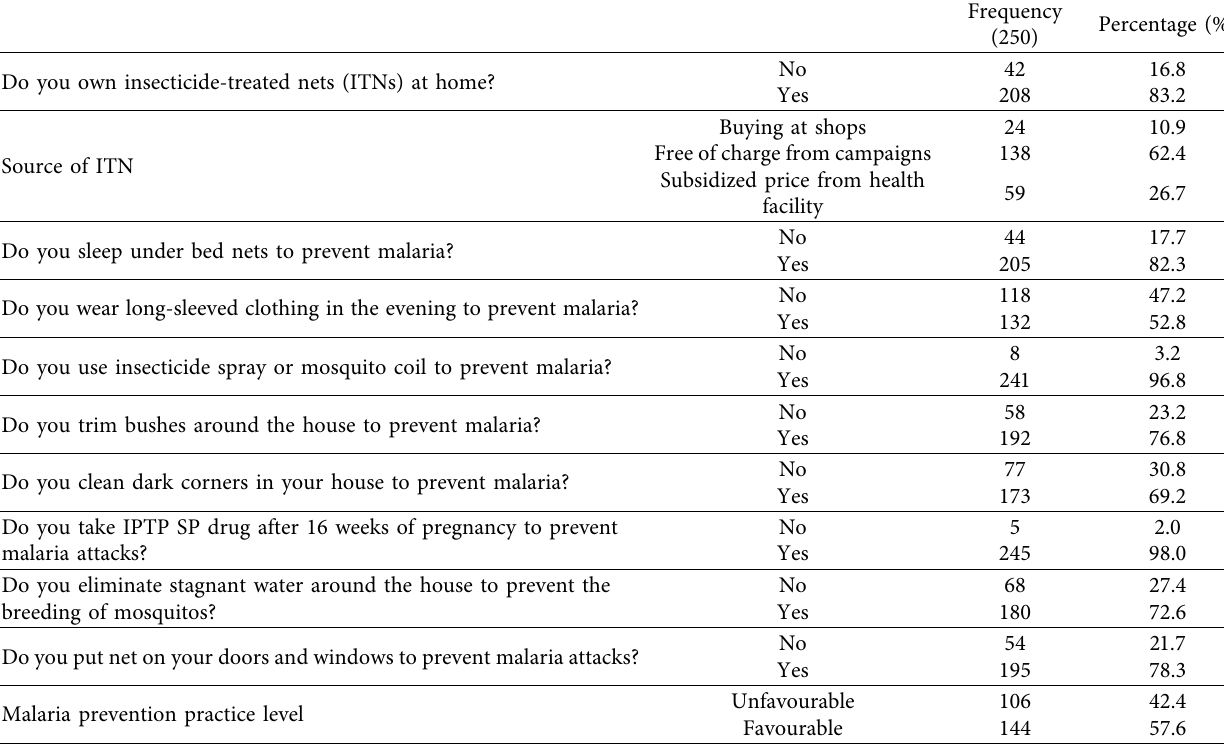
Table 4: Respondents practice of malaria preventive measures.